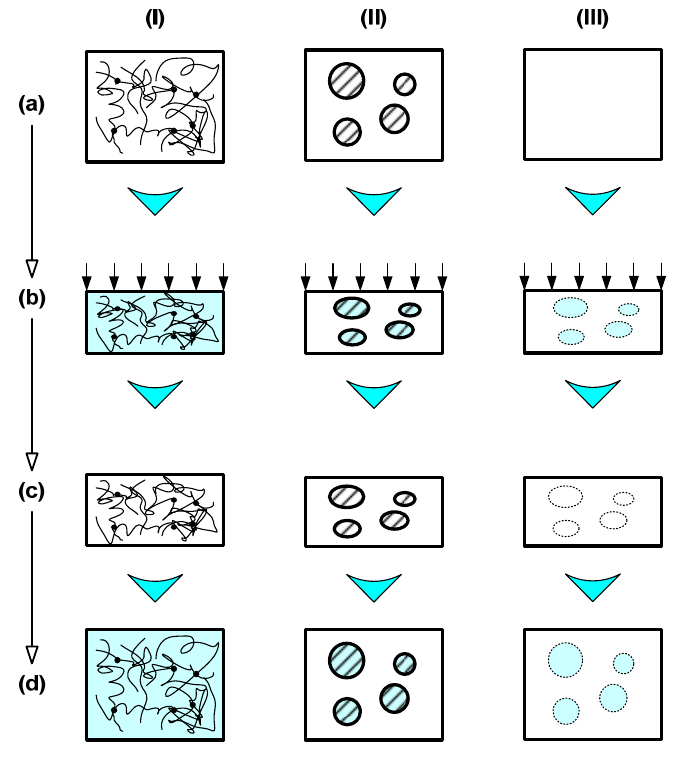
Figure 5. Basic working mechanisms for the heating-responsive SME in polymeric materials. ( I ) Dual-state mechanism (DSM); ( II ) dual-component mechanism (DCM); ( III ) partial-transition mechanism (PTM). ( a ) Original sample at low temperatures; ( b ) upon heating and compressing; ( c ) after cooling and constraint removal; and ( d ) after heating for shape recovery. (Modified from